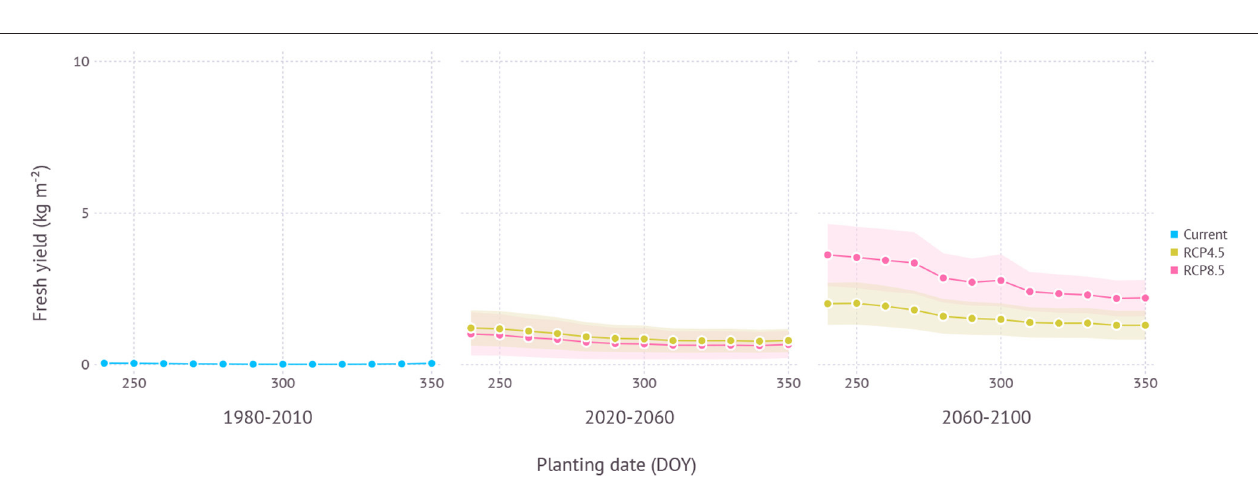
FIGURE 9 | Yield estimation within a range of planting dates under current and future climate projection in Gosan, Jeju which is a region that grows ND cultivar at a commercial scale. The current climate indicates simulation results with 30-years of normal weather data from 1980–2010. Shades represent a range of ± 1 standard deviation from the mean fresh yield.